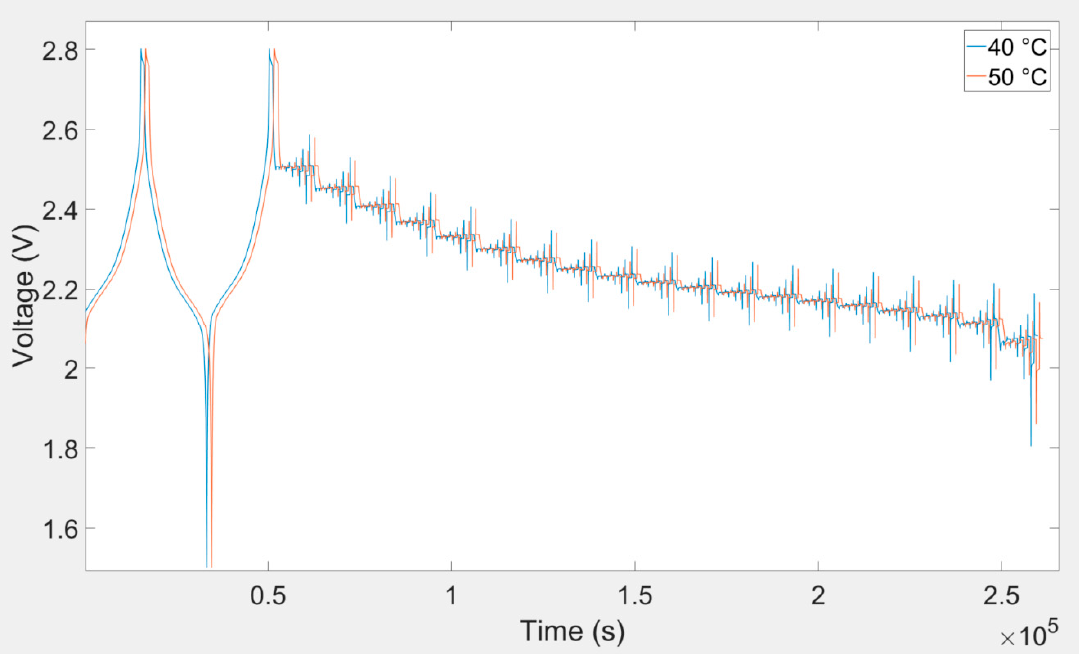
Figure 9. Battery cell voltage response owing to charging and discharging current pulse for 40 °C and 50 °C.